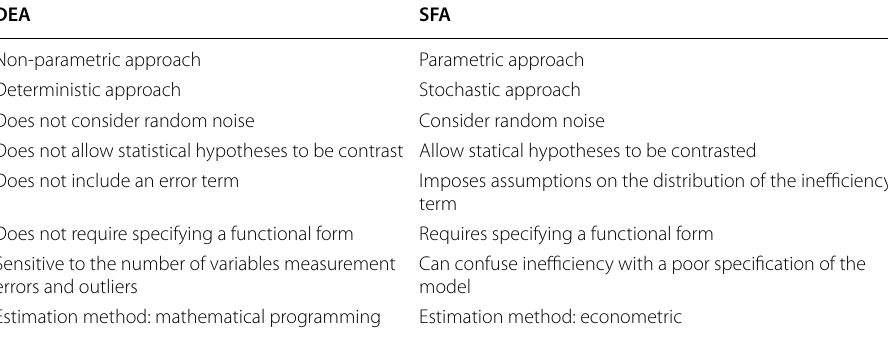
Table 5 Characteristics of DEA and SFA. Source : Serebrisky et al. (2016)